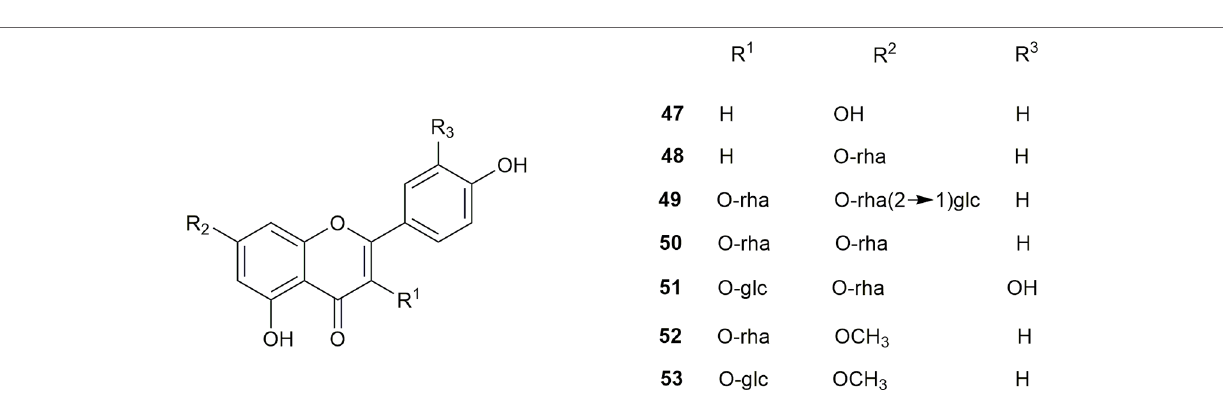
FIGURe 4 | The structures of flavonoids from S. grosvenorii